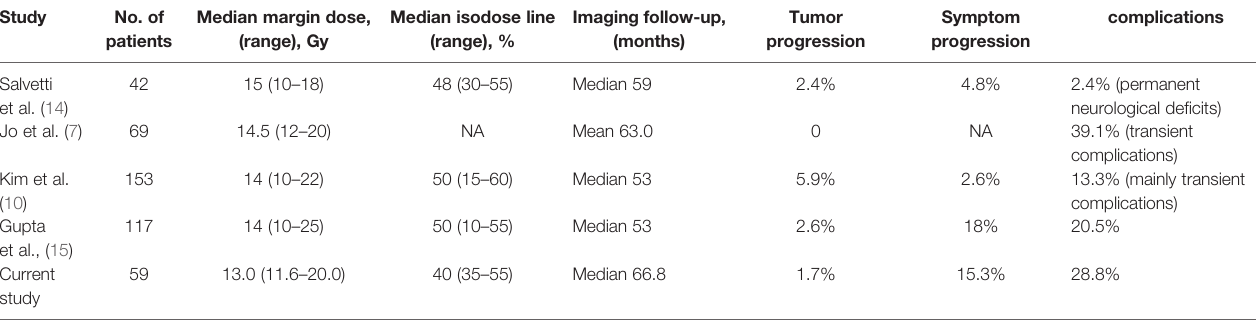
TABLE 4 | Literature review of GKRS for asymptomatic